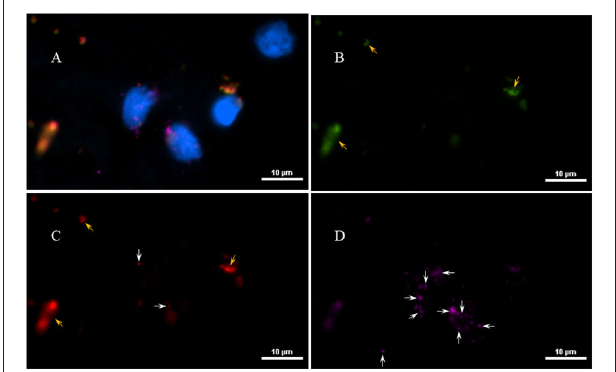
FIGURE 10 | Validation of RNA integrity on a fresh-frozen tissue sample from patient 12,577 autopsy tissue using RNAscope assay; (A) = merged. Tissue was stained with a 3-plex positive control probe POLR2A targeting DNA-directed RNA polymerase II RPB1, PPIB targeting cyclophilin B, and UBC that targets Ubiquitin C (D) . Absence of signal in POLR2A (B) and only 2 puncta of PPIB per cell (C) indicates that the quality of the RNA has been compromised. White arrows were pointing toward the fluorescence puncta and orange arrows toward autofluorescence of the tissue.